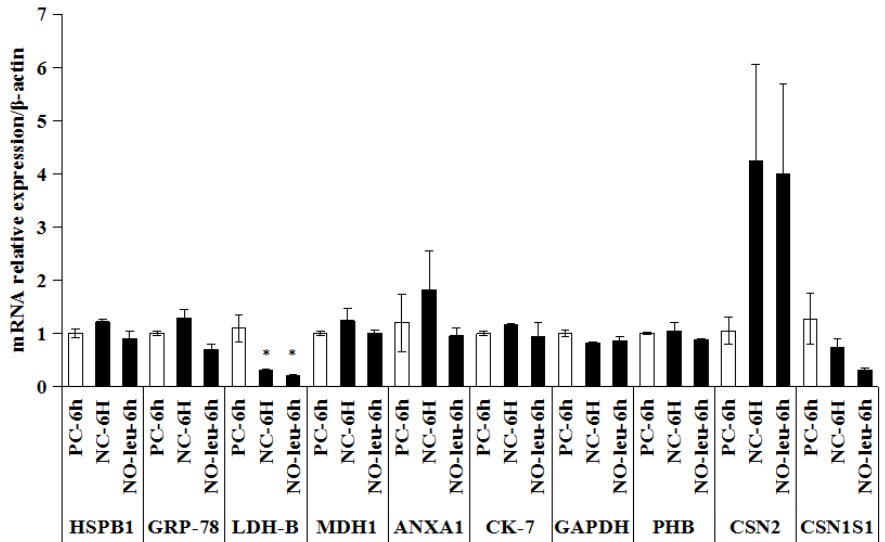
Figure 4. Verification test of candidate proteins obtained from isolated milk epithelial cells (MECs) in MAC-T cells after l -leucine limitations for 6 h by real time PCR. NC: Negative control, Earle’s Balanced Salts Solution + insulin (5 µ g / mL) + hydrocortisone (1 µ g / mL) + prolactin (5 µ g / mL); PC: Positive control, NC medium supplemented with 0.70 l -arginine, 0.15 l -histidine, 0.42 l -isoleucine, 0.45 l -leucine, 0.5 l -lysine, 0.12 l -methionine, 0.22 l -phenylalanine, 0.45 l -threonine, 0.04 l -tryptophan,